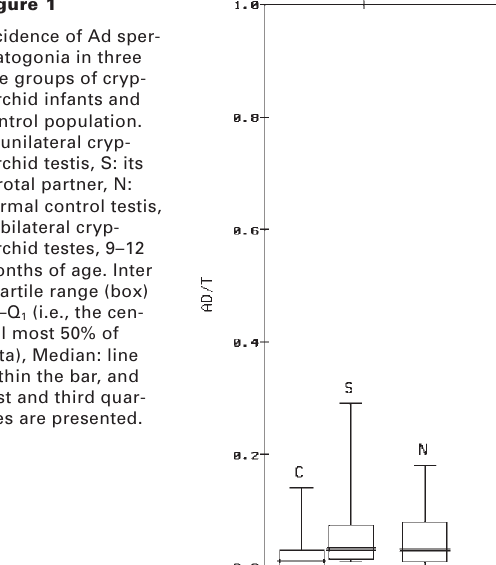
Incidence of Ad sper- matogonia in three age groups of cryp- torchid infants and control population. C: unilateral cryp- torchid testis, S: its scrotal partner, N: normal control testis, B: bilateral